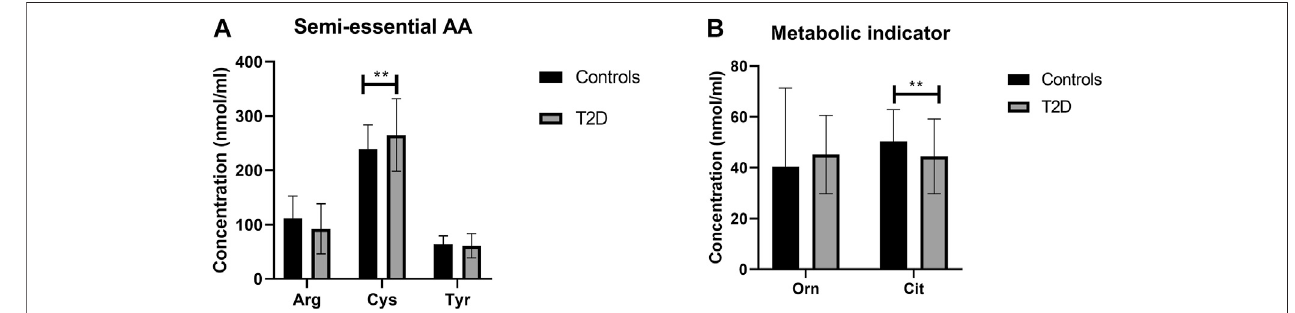
FIGURE4| Plasmaconcentrationofsemi-essential (A) andmetabolicindicators (B) aminoacidsintype2diabetes(T2D).Cysplasmaconcentrationwasincreased in T2D participants compared to healthy controls (A) . Cit plasma concentration was reduced in T2D compared to healthy control (B) . Plasma samples from T2D participants ( n (cid:2) 124) or healthy controls ( n (cid:2) 67) were prepared and deproteinized before total amino acid pro fi ling was carried out (unpaired independent t -test, ** <